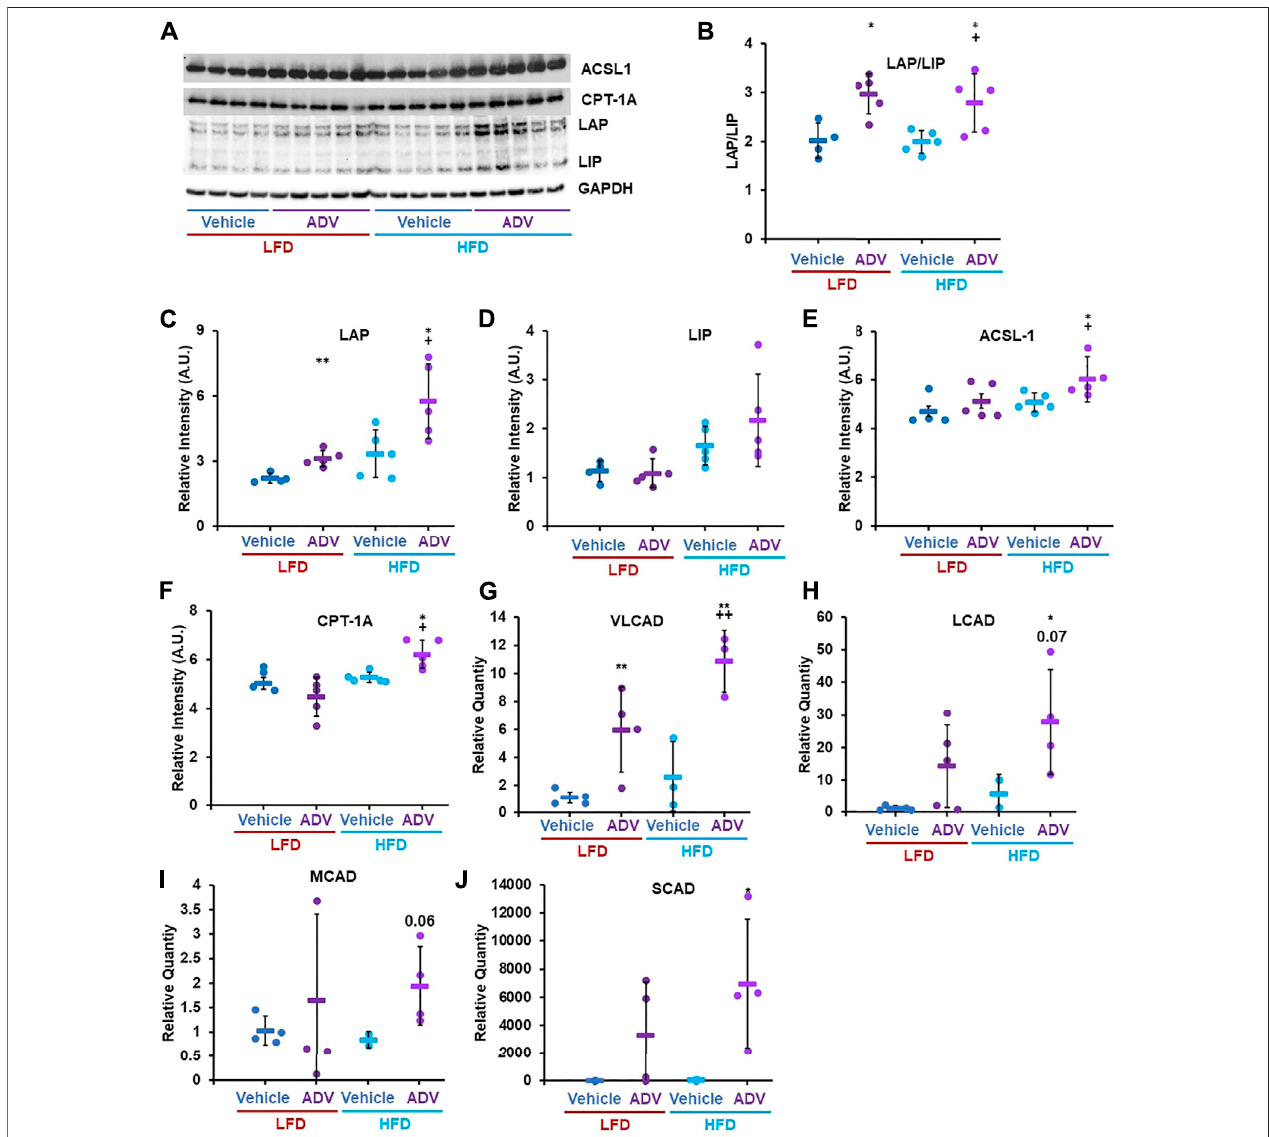
FIGURE 7 | Adefovir dipivoxil promotes the expression of fatty acid oxidation genes. (A) Representative western blot image against C/EBP- β (LAP and LIP isoforms),ACSL1,CPT-1A,andGAPDH. (B – F) Densitometricanalysisofthewesternblotinpanel (A) RelativeQuantity,asmeasuredviaRT-PCR,forVLCAD (G) ,LCAD (H) , MCAD (I) , and SCAD (J) Circles: individual animals, bars: average + - standard deviation. *: p < 0.05 vs LFD control, **: p < 0.01 vs LFD control, +: p < 0.05 vs HFD control, ++: p < 0.01 vs HFD control.